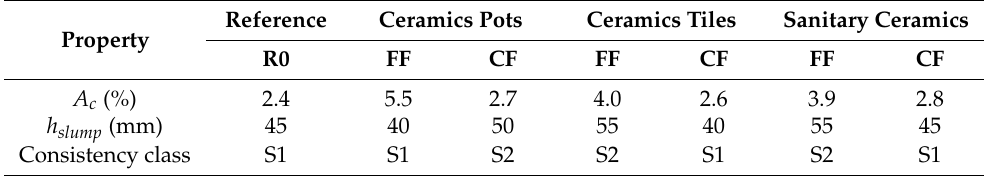
Table 4. The properties of the fresh